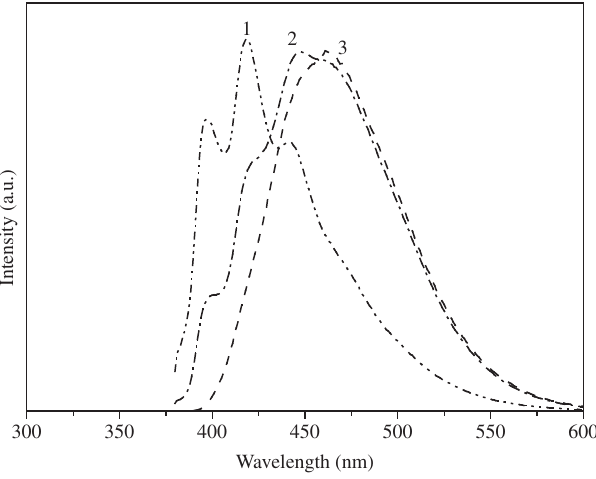
Figure 8. Fluorescence spectra of 9-AA in DGEBA solutions in concentrations (mol/L) of 1)1 x 10 -5 ; 2) 1 x 10 -4 ; 3) 1 x 10 -3 ( λ